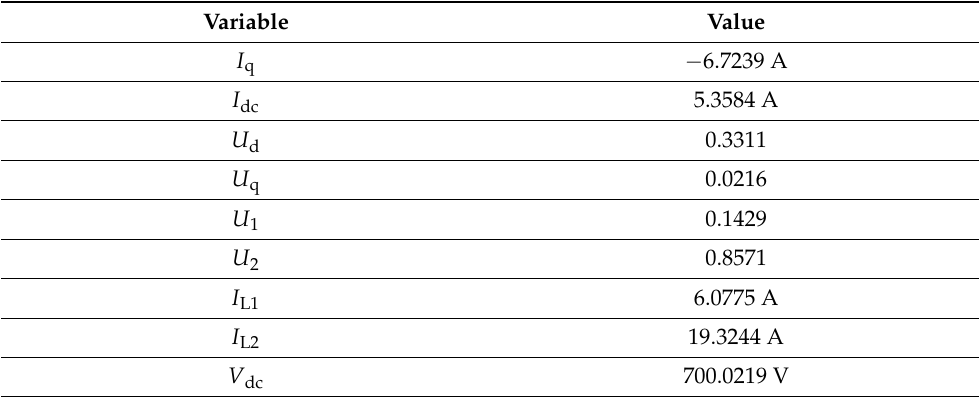
Table 3. Operating point: solution of Equation